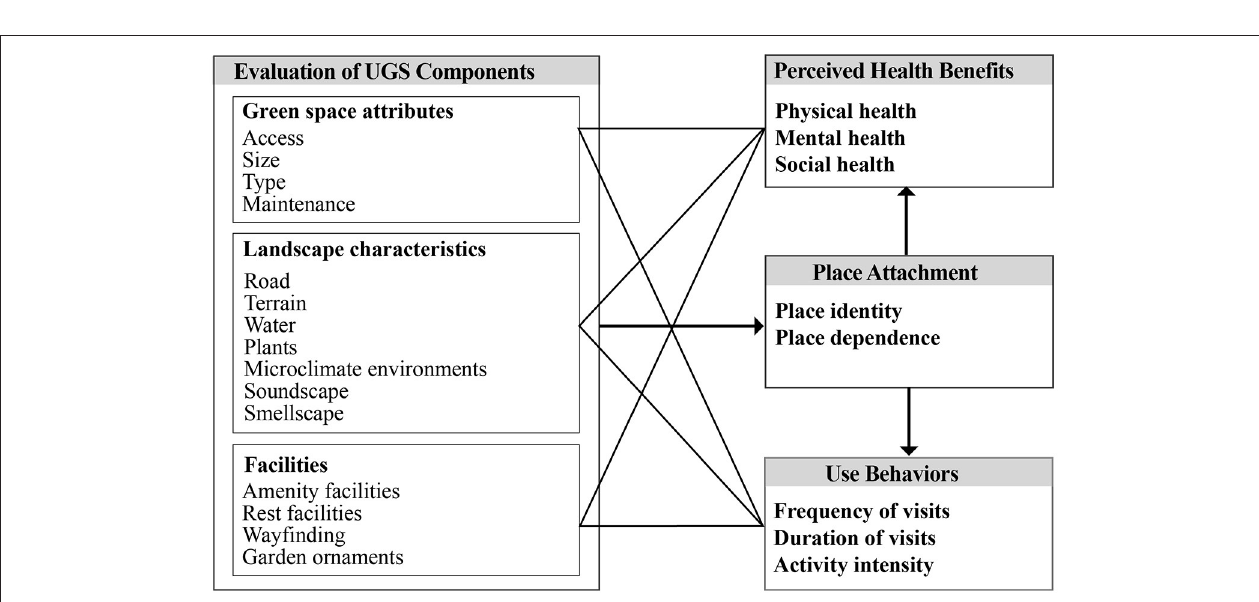
FIGURE 1 | Potential relationships between UGSs, place attachment, and use behaviors. (A) Possible causal relationships between UGSs, place attachment, and perceived health benefits. (B) Possible causal relationships between UGSs, place attachment, and frequency of visits. (C) Possible causal relationships between UGSs, place attachment, and duration of visits. (D) Possible causal relationships between UGSs, place attachment, and activity intensity.